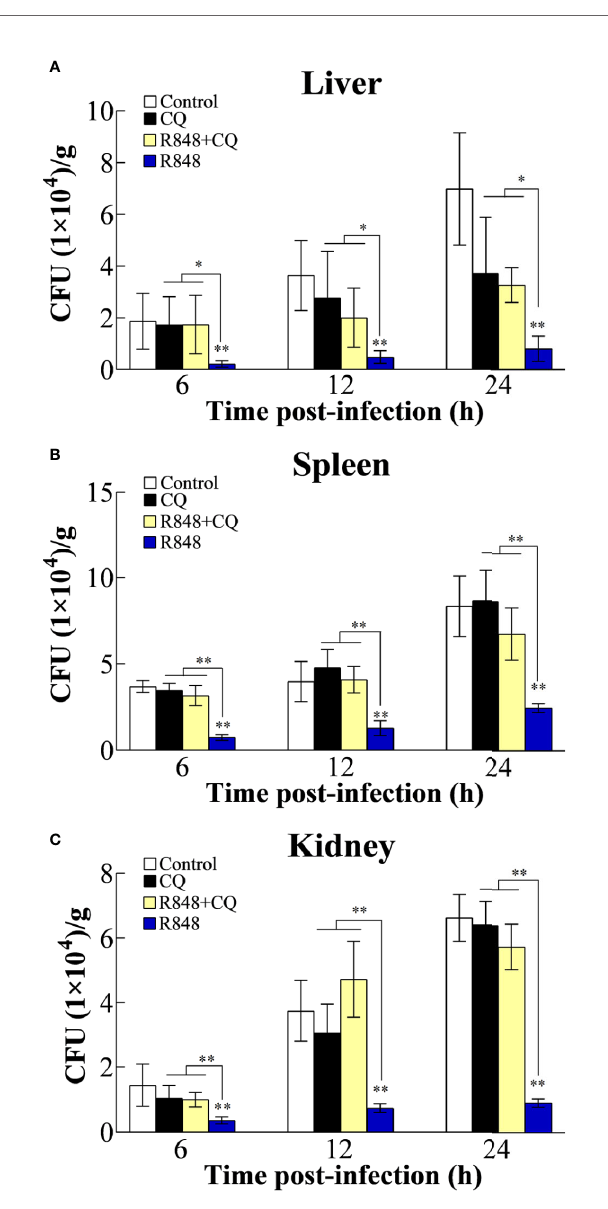
FIGURE 1 | Effect of R848 and chloroquine (CQ) on bacterial infection. Golden pompano administered with R848, CQ, R848 plus CQ, or PBS (control) were infected with Edwardsiella tarda , and the amount of bacteria in the liver (A) , spleen (B) , and kidney (C) were determined at different time points. All data are shown as the means ± SD (N = 5), and the statistical signi fi cance is indicated. *P < 0.05, **P < 0.01.